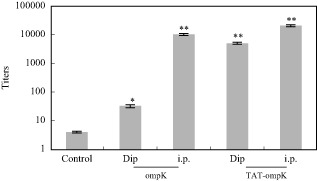
Specific antibody titres detected by ELISA in the sera of fish vaccinated with different ways.Dip: Dip immersion vaccination; i.p.: intraperitoneal injection vaccination. *P < 0.05; **P < 0.001.